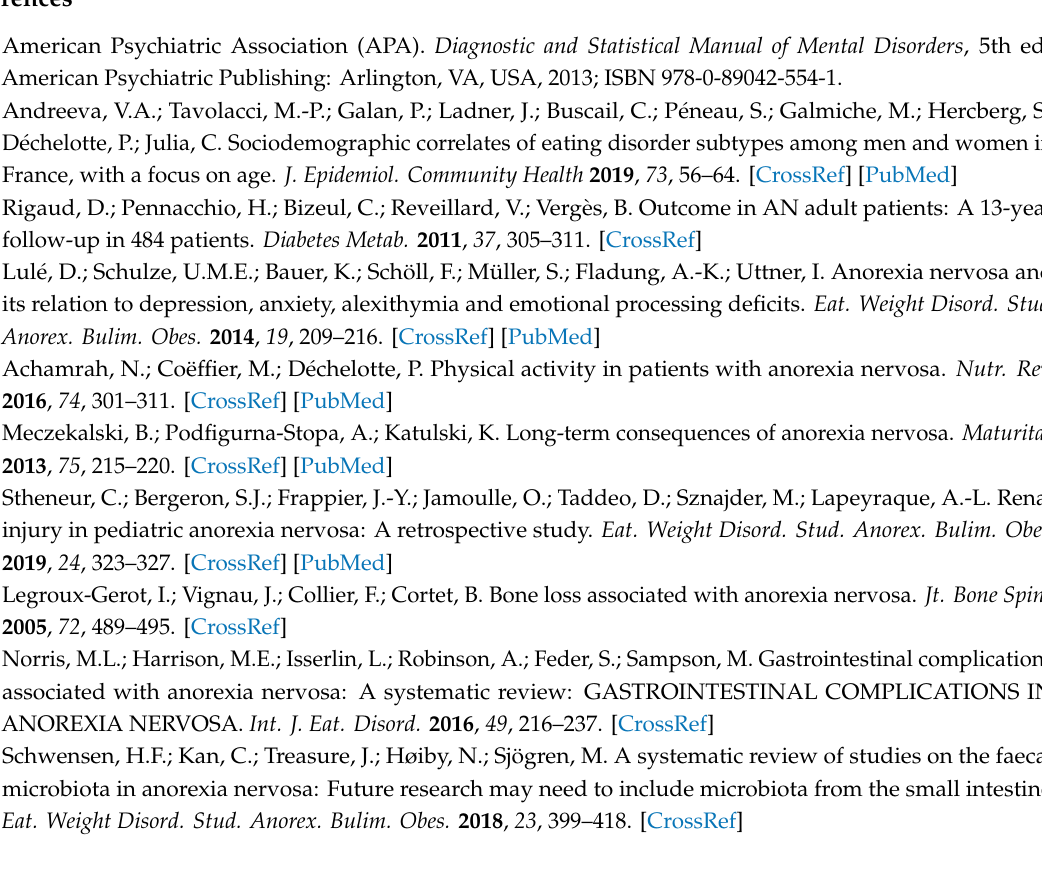
Table S1: Primers sequences used for